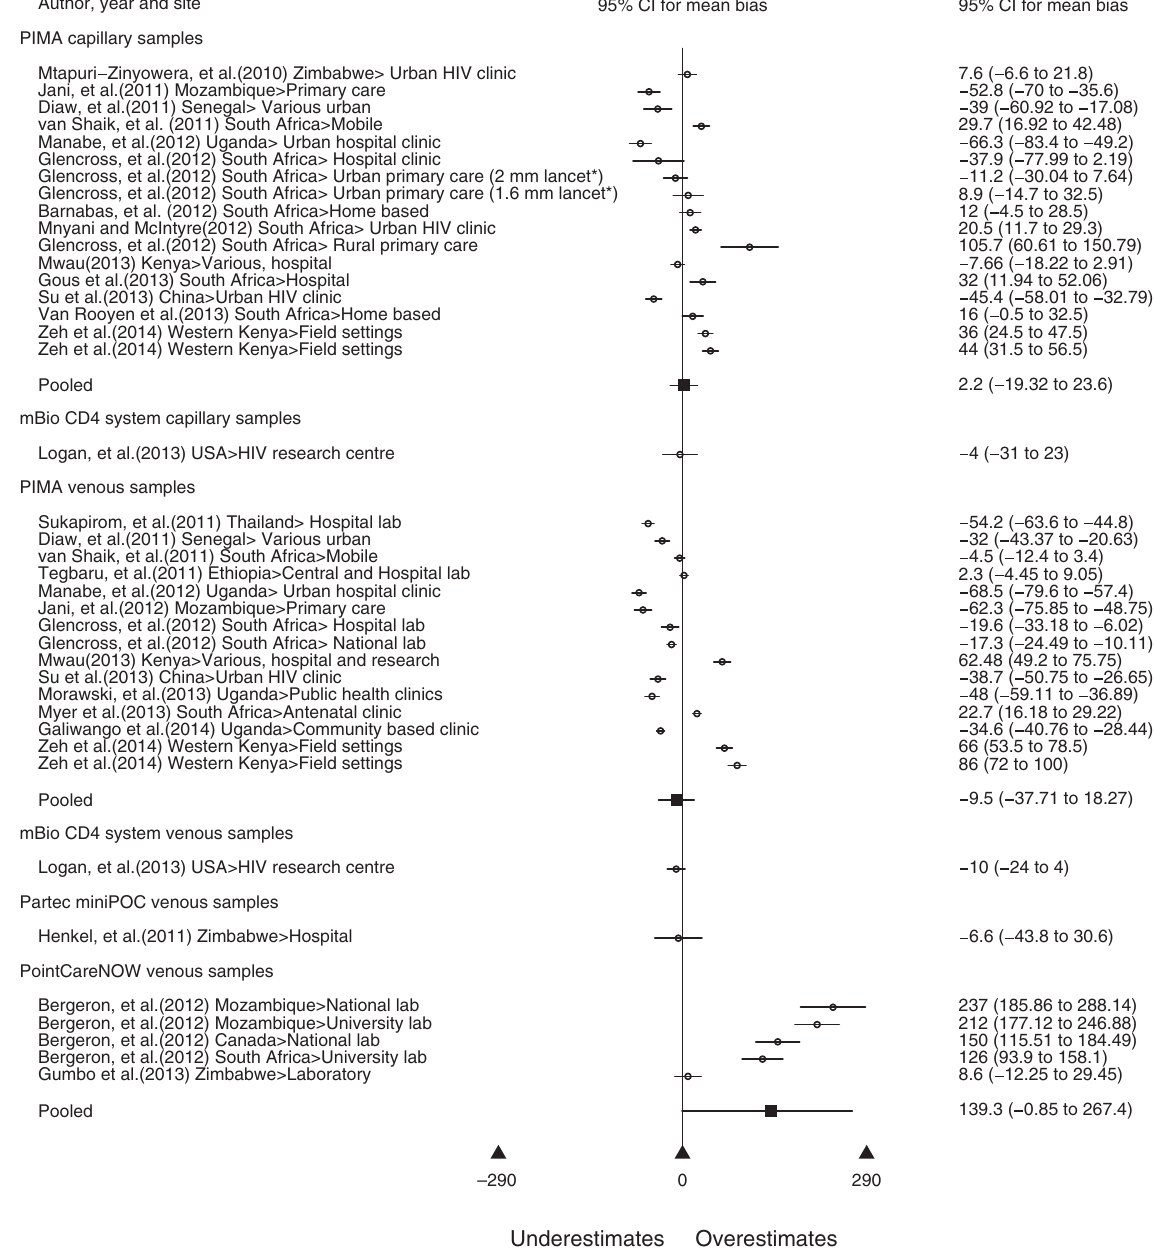
Figure 3. Bland – Altman results. Forest plot and pooled results, grouped by substrate used and POC